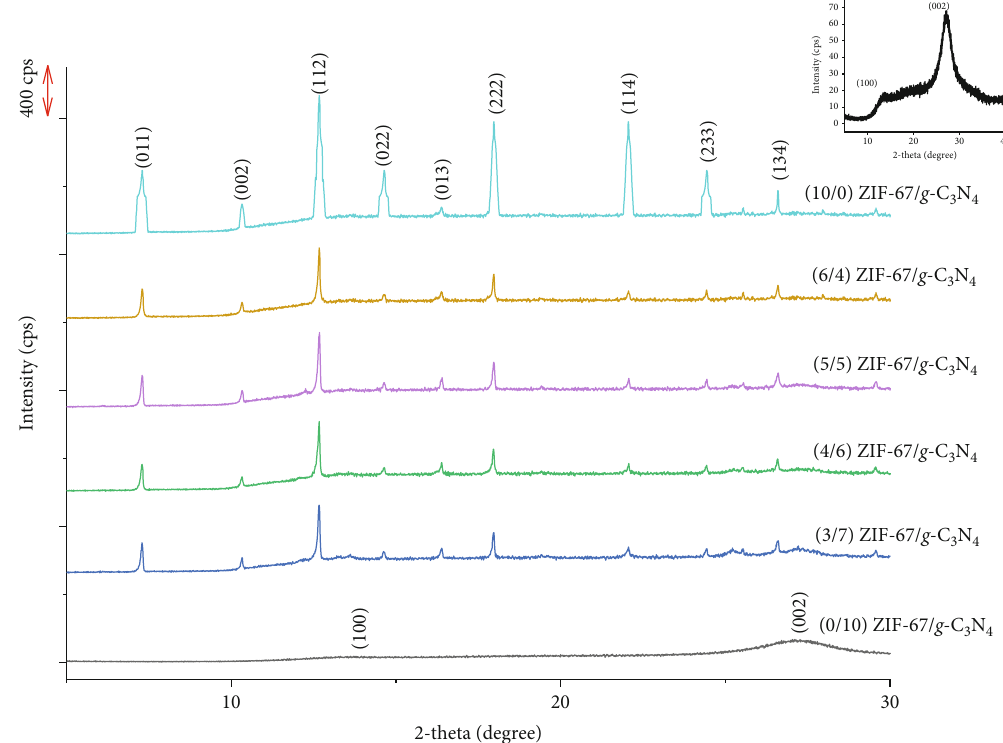
Figure 1: XRD patterns of ZIF-67, g -C